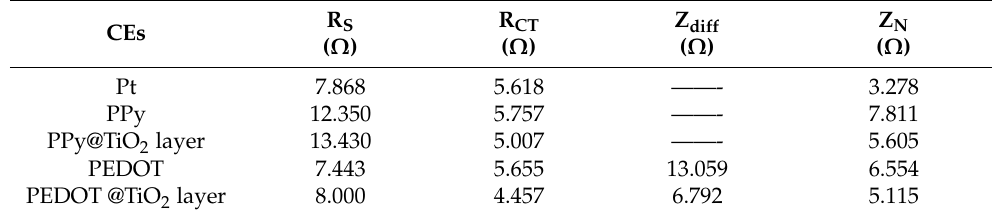
Table 2. EIS parameters of the symmetric cells with various CEs and [Co(bpy) 3 ] 2+/3+ redox couple.